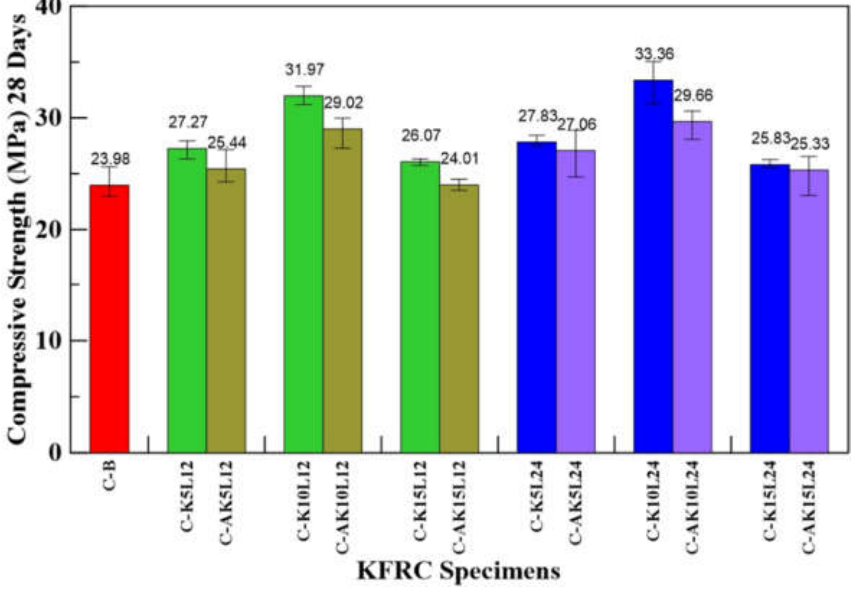
Figure 4. Compressive strengths of the benchmark concrete and the KFRC specimens under various weight